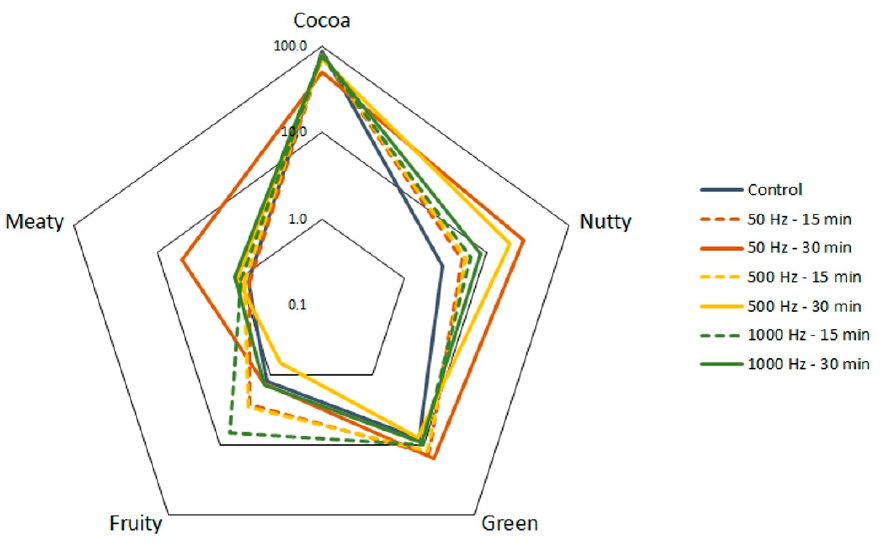
Figure 3. The aroma profile radar for the untreated and plasma-treated RTD coffee.